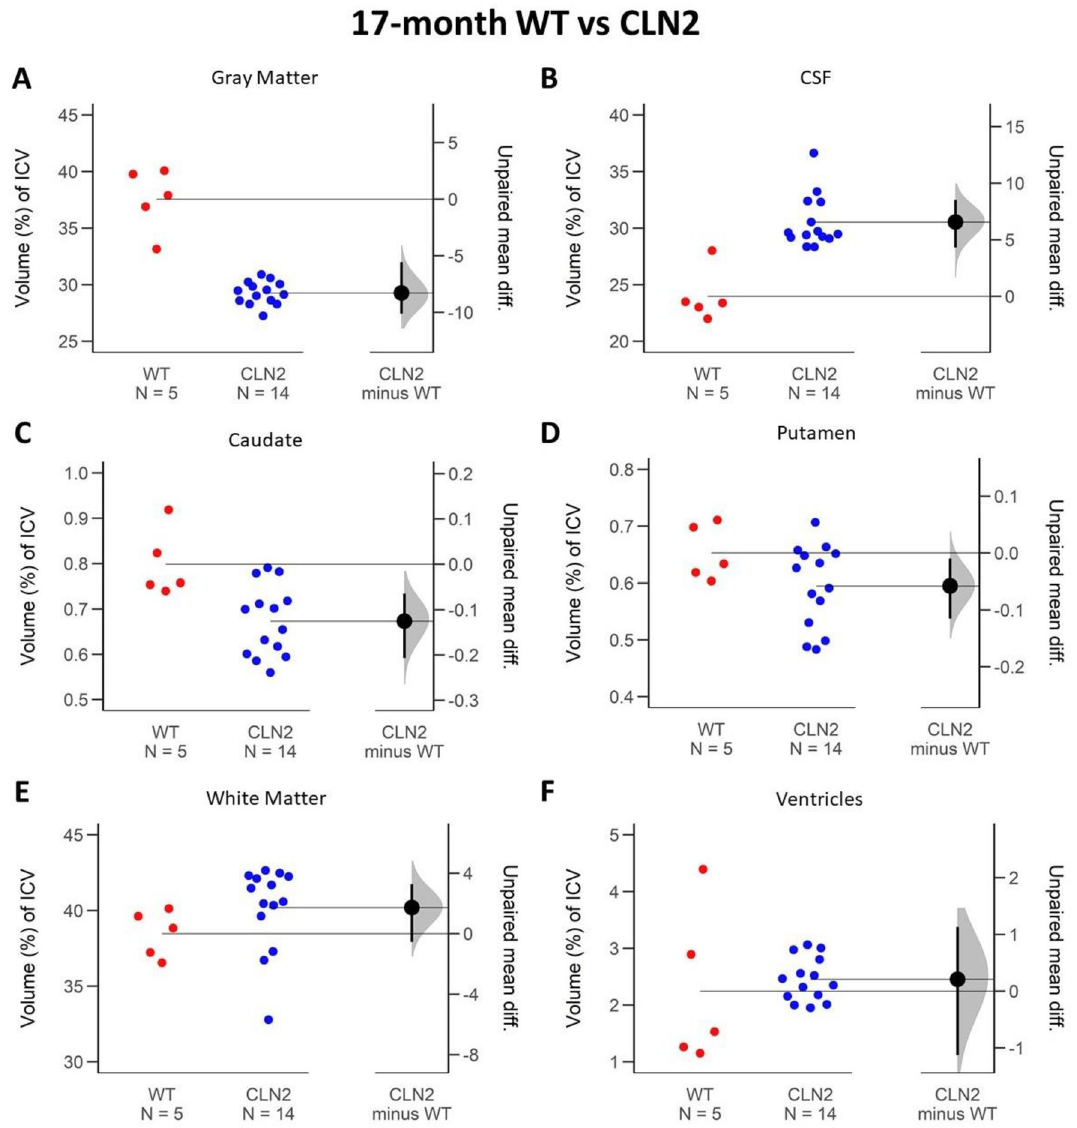
Figure 4. Late disease stage (at 17-months of age) ICV proportion comparison of brain regions between WT and CLN2 R208X/R208X cohorts. The average difference and 95% confidence interval (black circle with error bar in CLN2 minus WT column) do not cross the horizontal line at zero and indicate reliable measurement difference between the cohorts in gray matter ( A ), CSF ( B ), caudate ( C ), and putamen ( D ). The average difference and 95% confidence intervals (black circle with error bar in CLN2 minus WT column) cross the horizontal line at zero for white matter ( E ) and ventricles ( F ), indicating reliable measured difference is